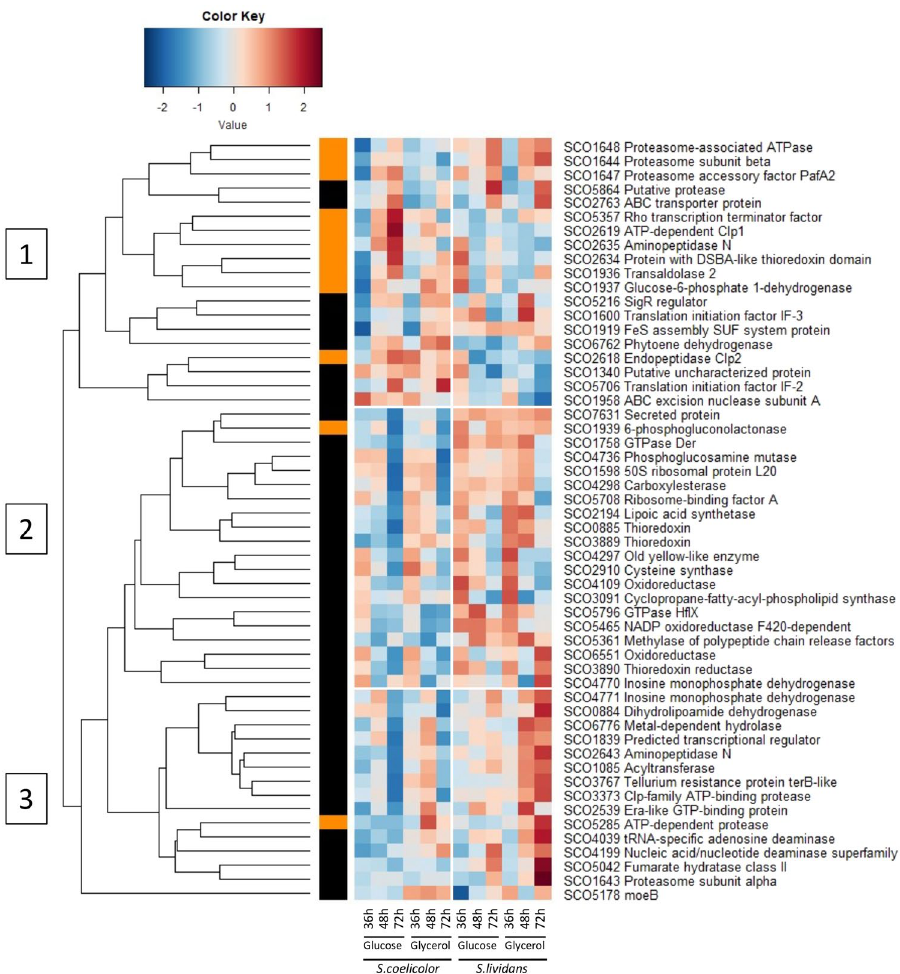
Figure 8. Heatmap representation of proteins belonging to the SigR regulon (clusters 1 to 3) with significant abundance change (ANOVA, adjusted p value < 0.05) between S. coelicolor (M145) and S. lividans (TK24) with either glucose or glycerol as main carbon source, for 36, 48 and 72 h. Protein identifiers are indicated as SCO numbers for both strains and by predicted functions. The quantification methods are displayed in the vertical bar indicating proteins quantified by Spectral Counting (orange) or XIC